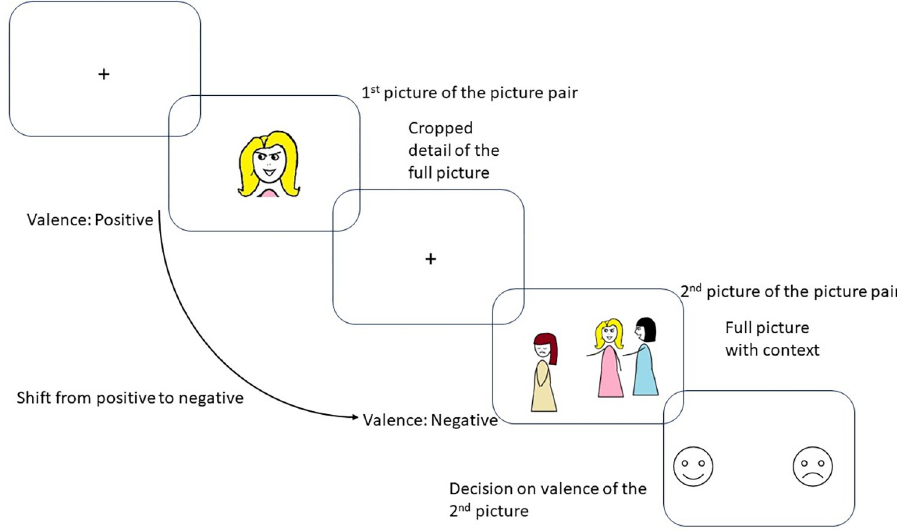
Fig 1. Schematic representation of a sequence of trial in the Emotional Shifting Task. An example for shifting from positive to negative emotion.